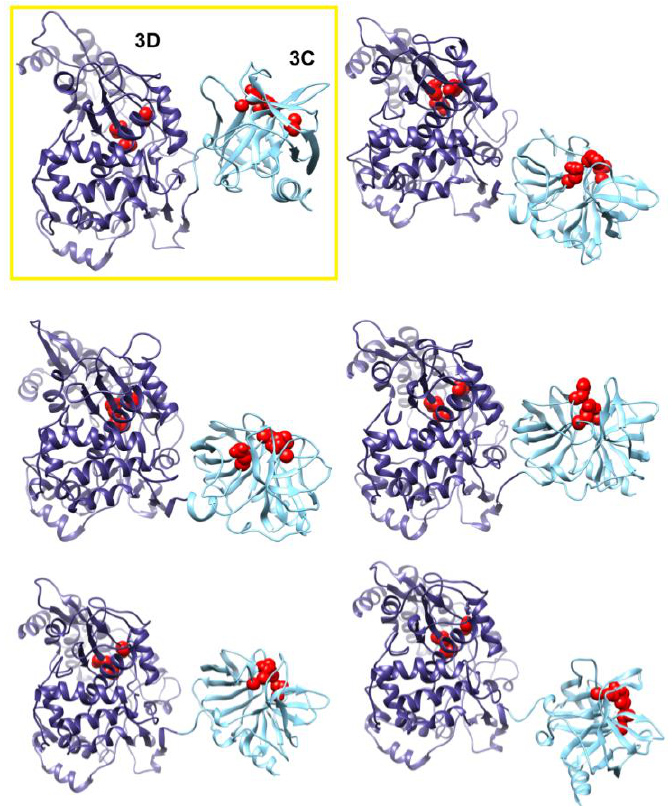
Figure 7. Accelerated MD reveal dynamic interface between 3C and 3D domains. Shown are five representative conformations of 3CD sampled during the accelerated MD simulations (including both compact and extended conformations), revealing the dynamic nature of the interface between the two domains of the protein. The interface in the compact conformation from the conventional MD is shown in a yellow box for comparison. The 3C and 3D domains are colored cyan and blue, respectively; active-site residues of the protease (His-40, Glu-71, Cys-147) and polymerase (Asp-416, Asp-511, Asp-512) are shown as red spheres to help identifying the relative orientations of the two domains.